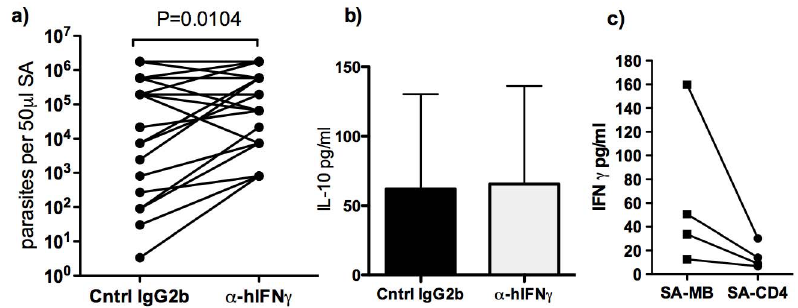
Figure 4. Endogenous IFN c limit parasite replication. a) Parasite load in ex-vivo SA culture of VL patients (n=31) treated with neutralizing anti- human-IFN c antibodies or isotype control IgG2b antibodies for three days. Parasite load was determined by limiting dilution on NNN-blood agar medium. b) IL-10 levels in SA culture supernatants (n=10), treated as described in a. c) Effect of CD4 depletion on spontaneous IFN c production in SA-biopsy cultures. Each dot represents one sample, paired samples connected by a line. Comparison between treatments was made using Wilcoxon matched paired test and statistical significances are indicated in the graphs when P , 0.05.